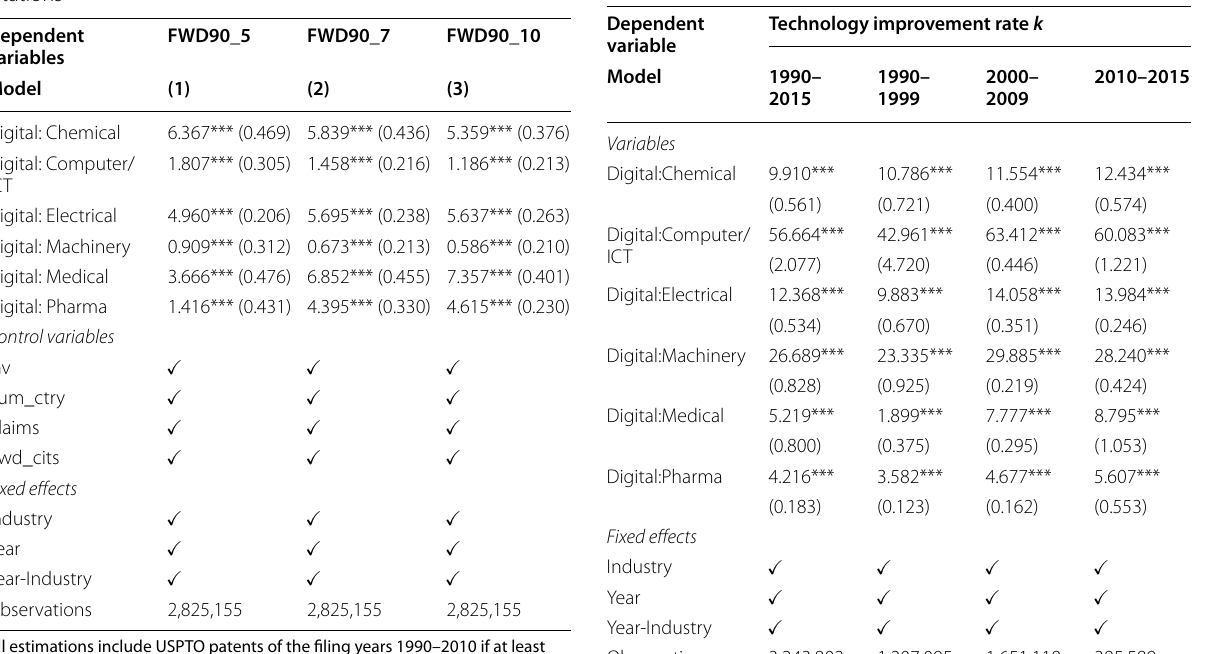
Table 12 The digital domain and technological improvement rates: time period estimates across